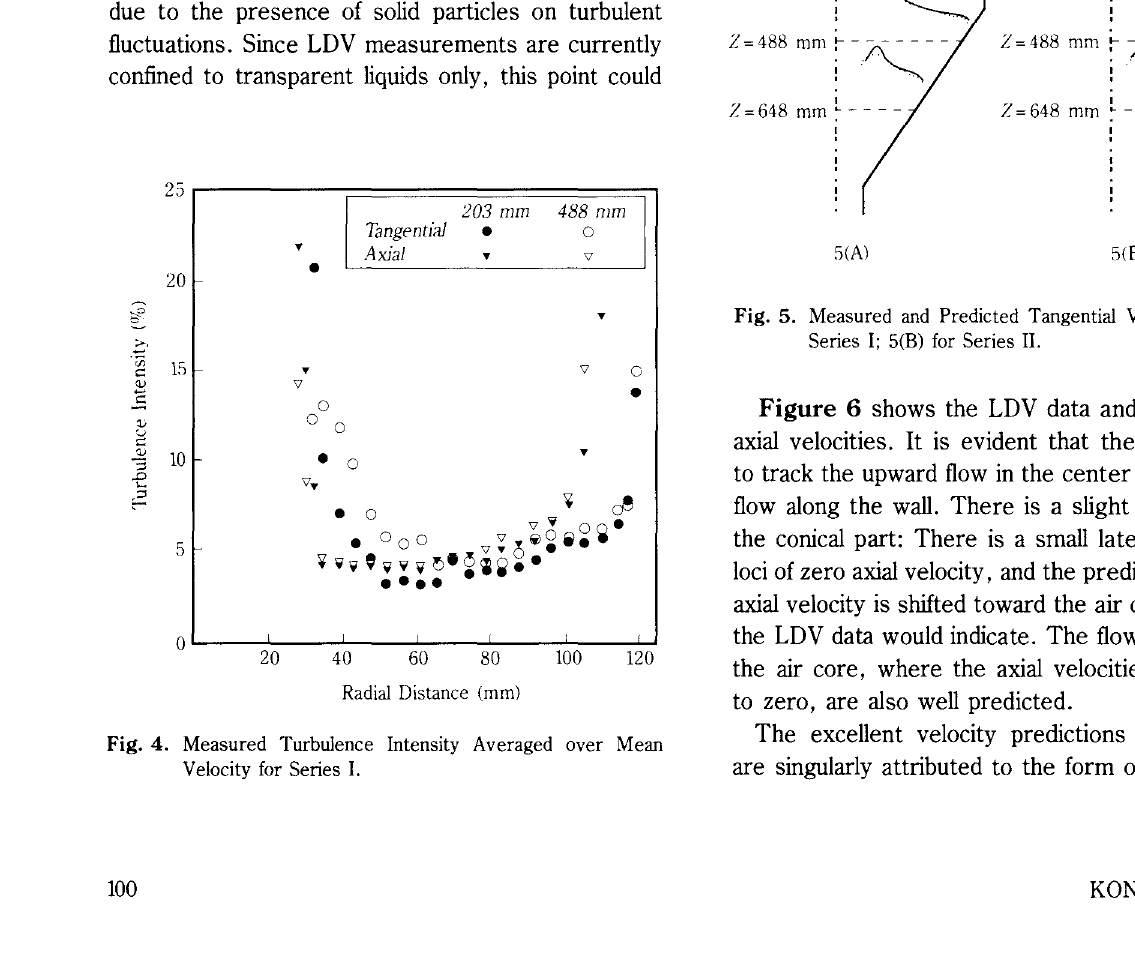
Fig. 5. Measured and Predicted Tangential Velocities. 5(A) for Series I; 5(8) for Series